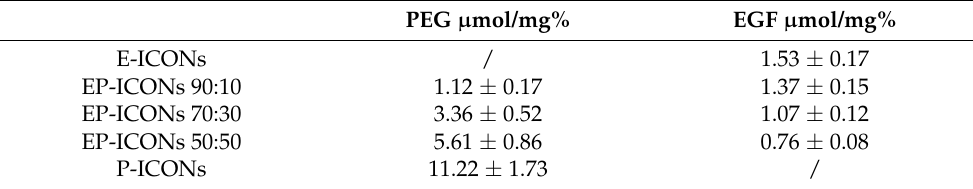
Table 1. Composition of inulin complex nanoaggregates (ICONs) in terms of µmol/mg% of polyethylenglycol (PEG) and/or epidermal growth factor (EGF).